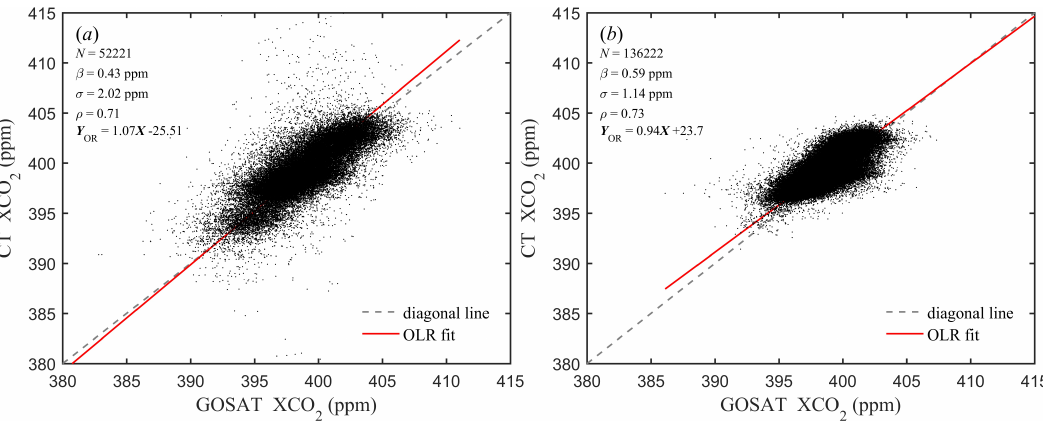
Figure 13. The scatter plots of the GOSAT and CT2017 XCO 2 ( a ) over land and ( b ) over the ocean. N represents the total number of GOSAT retrievals after data quality control in 2015.